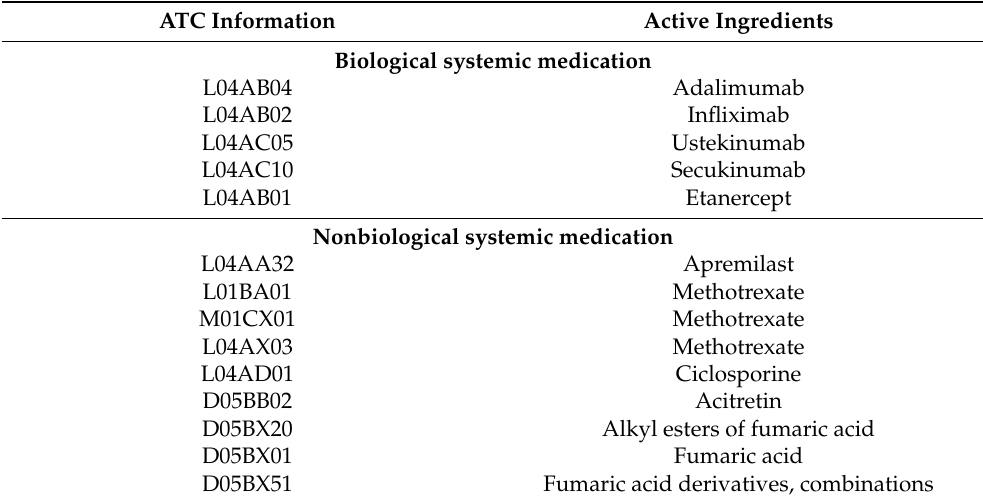
Table 2. Substances indicating a severe form of the disease (approval before